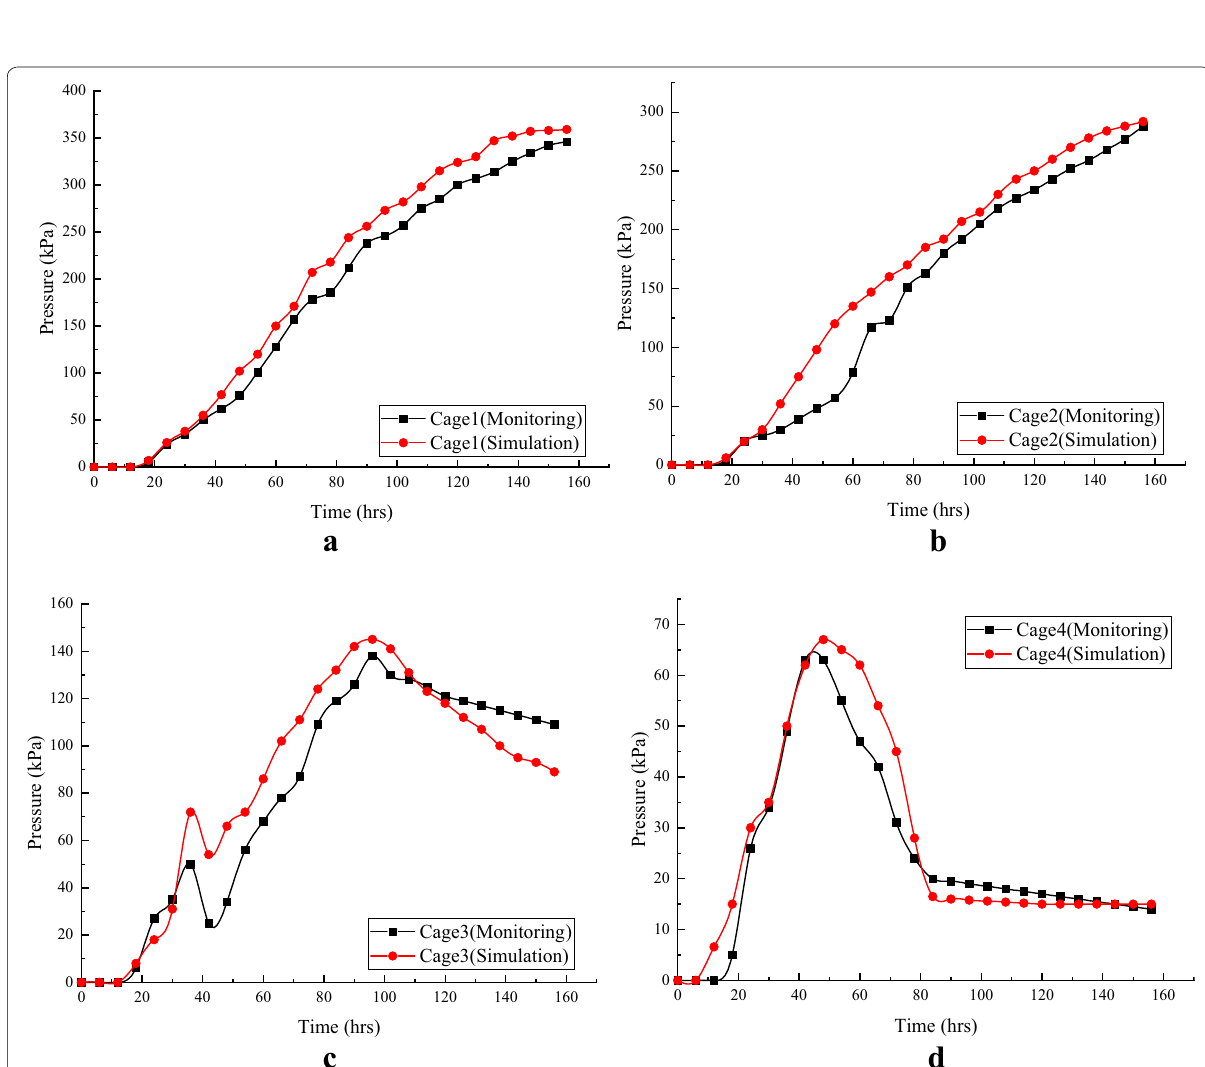
Fig. 14 Comparison of the pressure development with time between simulation and measurement corresponding to the sensors of C1 ( a ), C2 ( b ), C3 ( c ) and C4 ( d